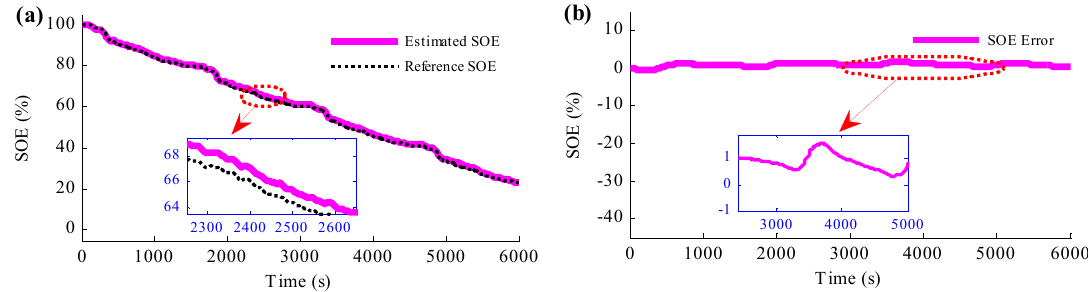
Figure 10. Experimental results when the current sensor works properly: ( a ) SOE estimation results; ( b ) SOE estimation error.